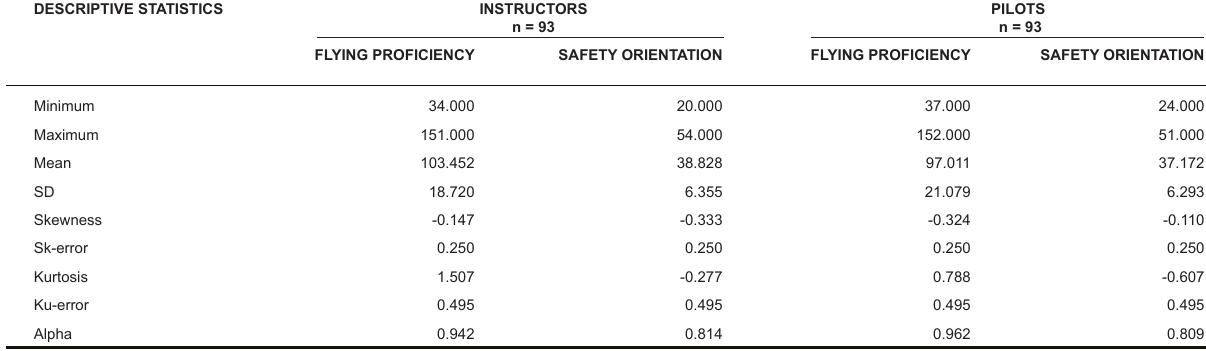
TABLE 2 Descriptive statistics of the responses of the flight instructors and pilots on the two scales of the